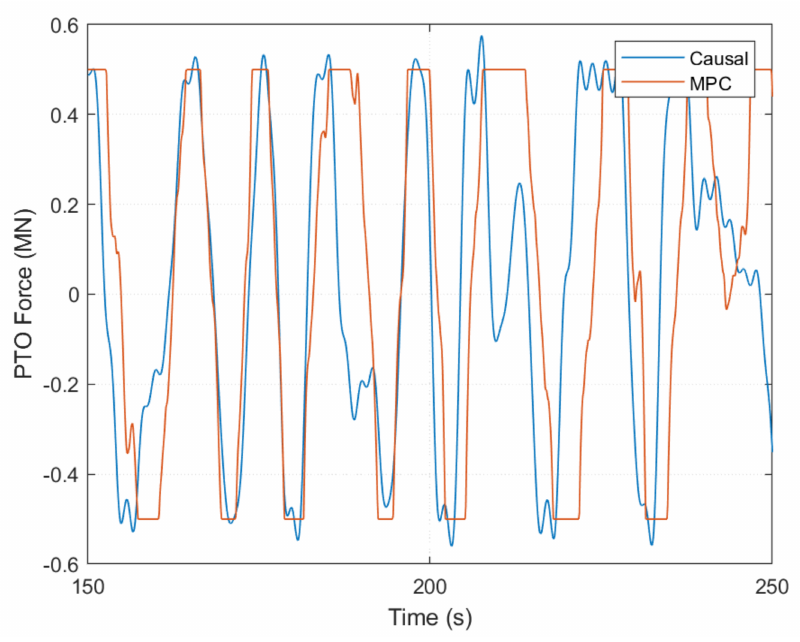
Figure 17. Time domain response comparison of PTO force with force limit = 0.5 MN. Significant wave height Hs = 1.0 m, peak period Tp = 16 s.